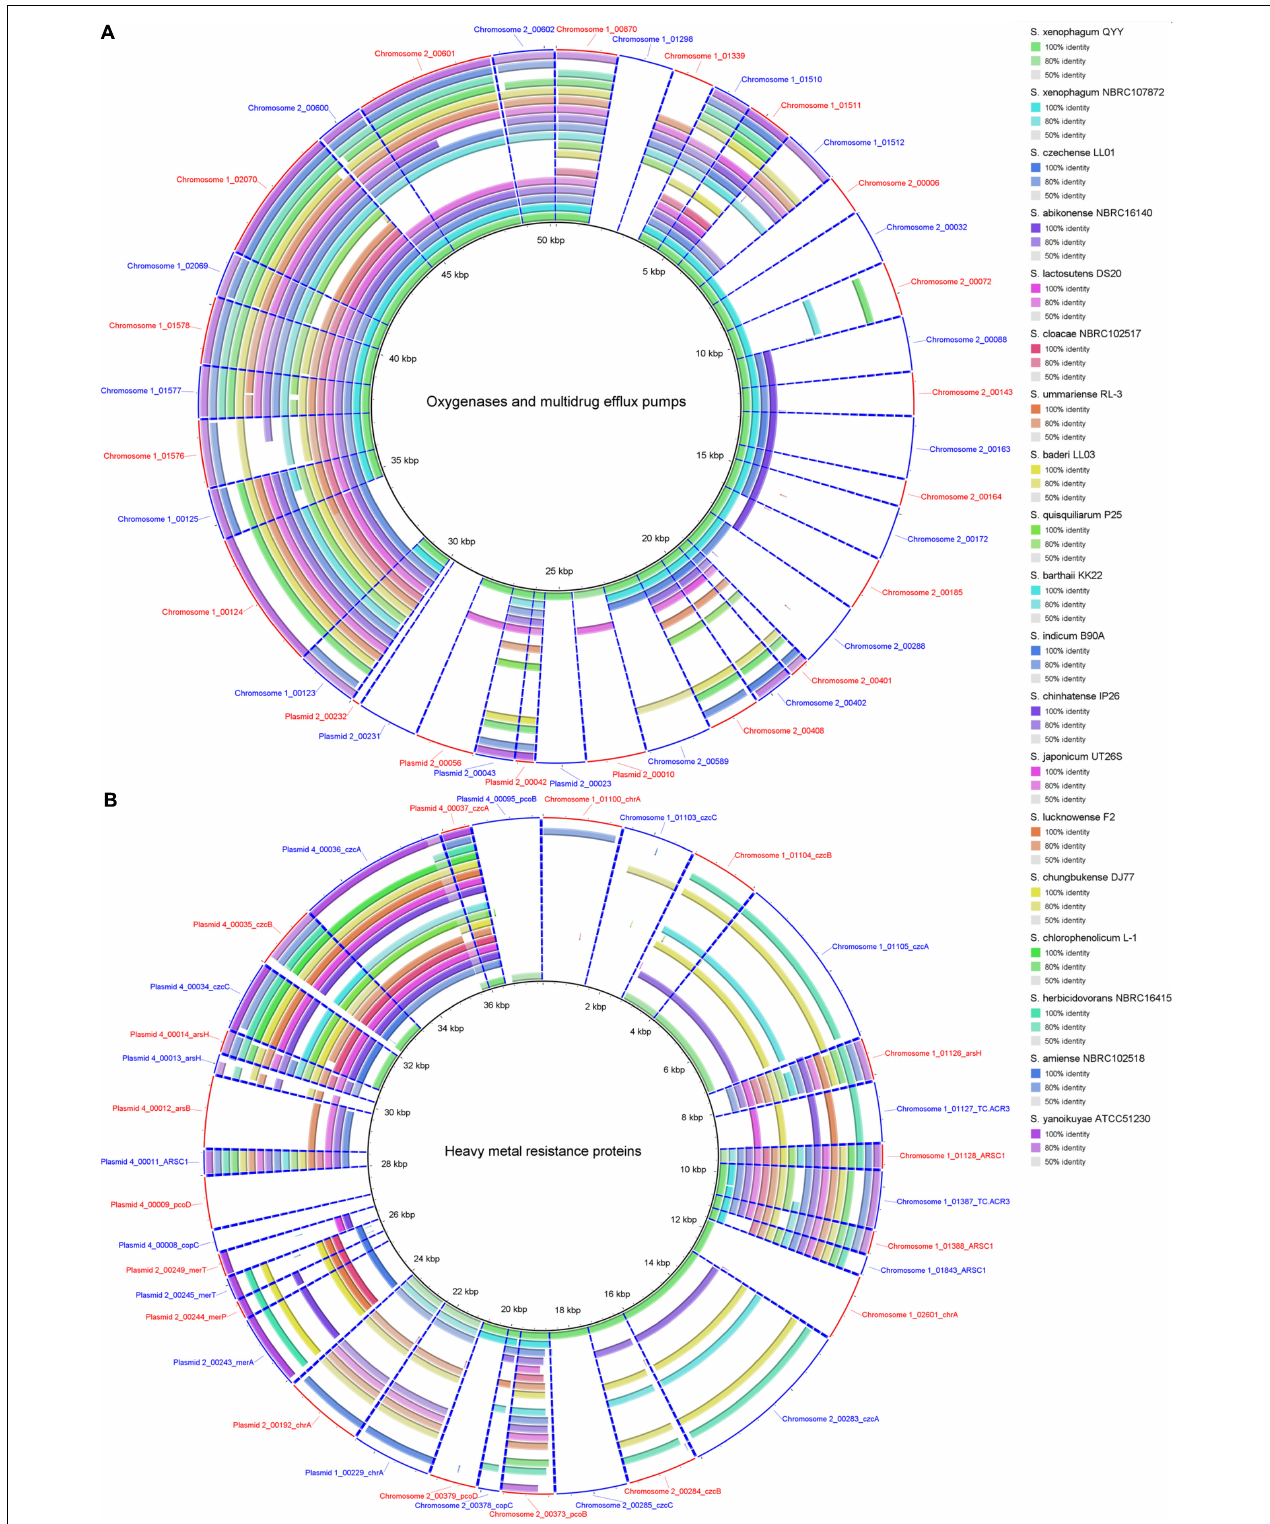
FIGURE 6 | Homology search of related protein sequences of strain C1 T against the 19 other Sphingobium genomes. These proteins are listed in Supplementary Table S5 . Each ring represents the Blastx comparison result against a genome. The presence/absence of homologous gene is visually presented, and the gradation of color indicates sequence identity. (A) Oxygenases and multidrug efflux pumps. (B) Heavy metal resistance proteins.